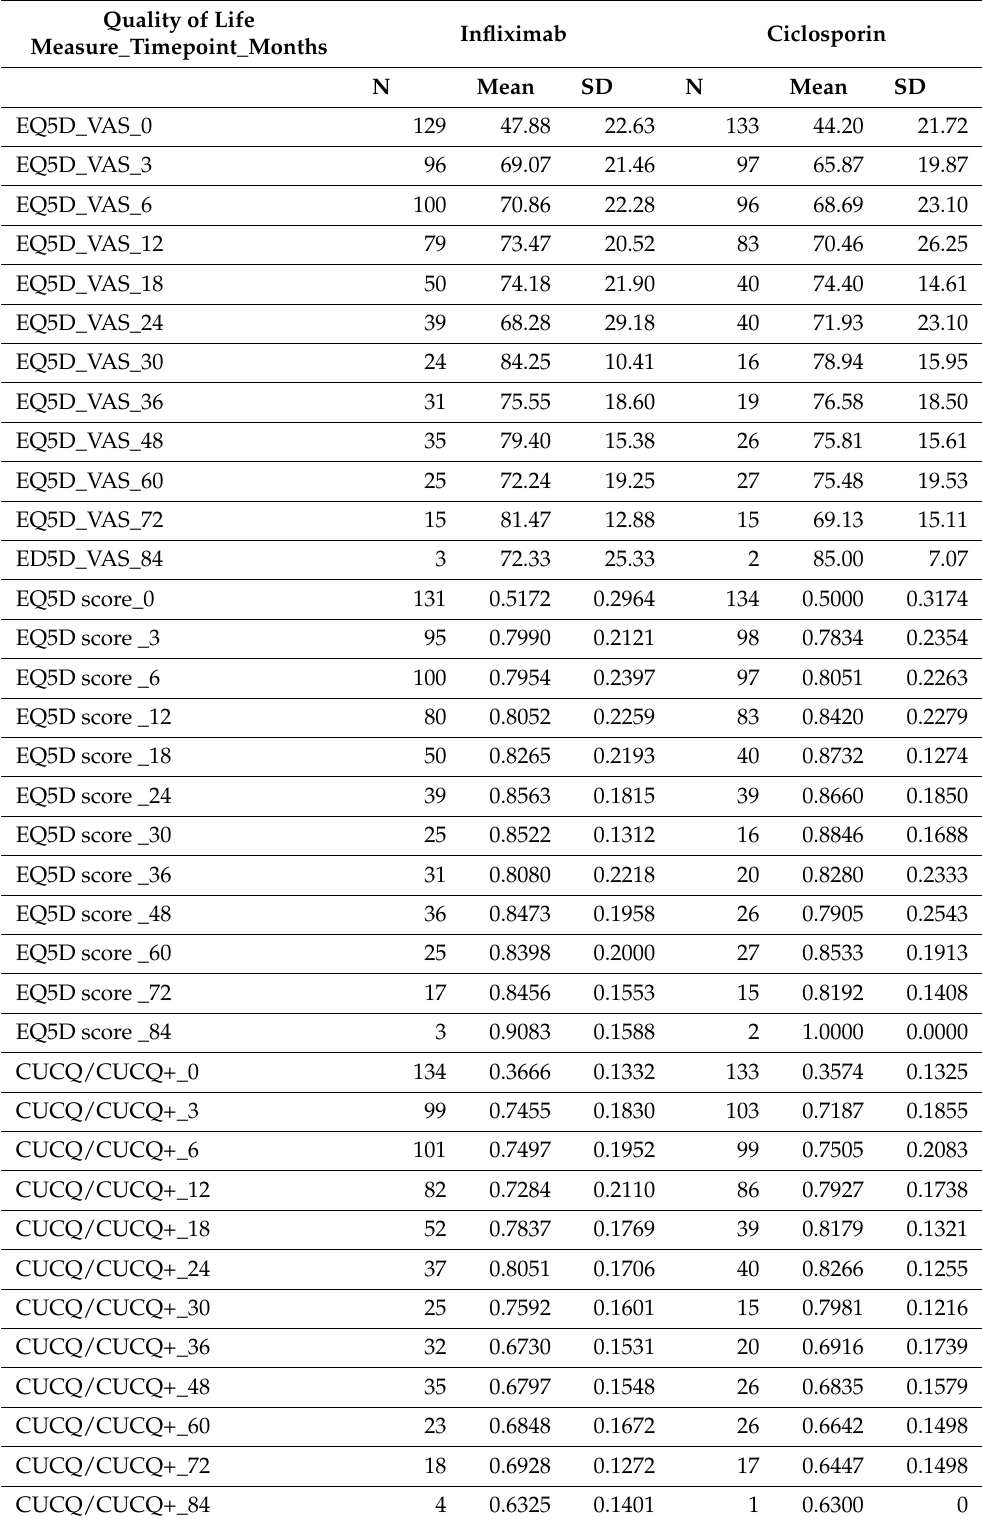
Table 2. Mean (SD) EQ5D VAS, EQ5D score and CUCQ/CUCQ+ scores for the infliximab and ciclosporin treatment